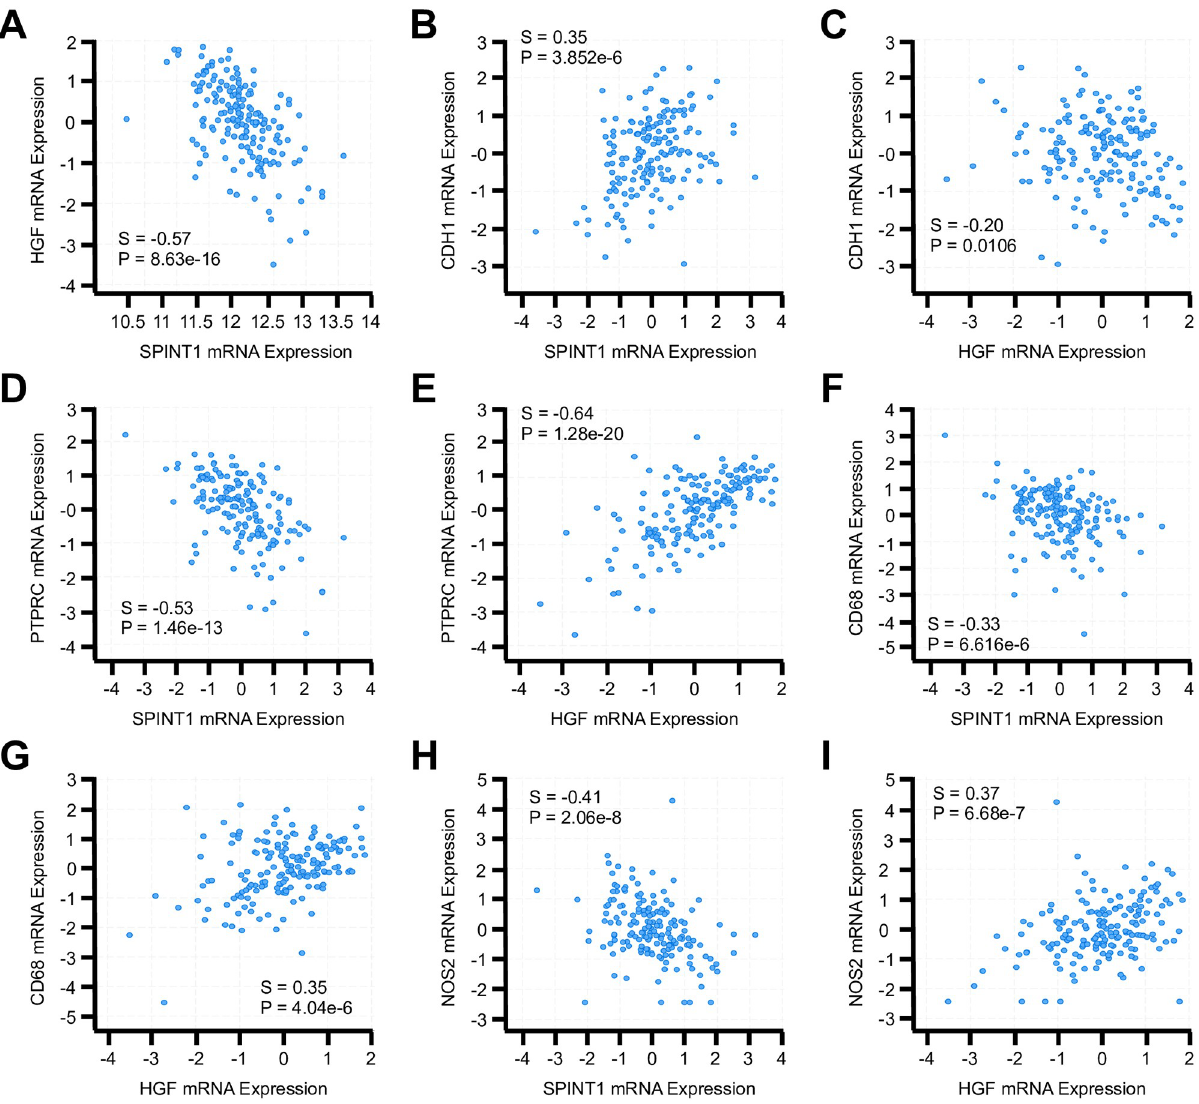
Fig 2. HAI-1 mRNA expression inversely associates with HGF and predicts for poor tumor immunogenicity. Patient mRNA profiles from the OncoSG dataset were evaluated for expression of HAI-1 ( SPINT1 ) and HGF . The expression of these genes were related to (A) each other, (B, C) the epithelial surrogate CDH1 , (D, E) the pan-leukocyte marker CD45 ( PRTPC ), (F, G) the macrophage marker CD68, or (H, I) the M2 macrophage marker iNOS ( NOS2 ). The Spearman’s Correlation Coefficient (D) and P value of all potential interactions are displayed above.